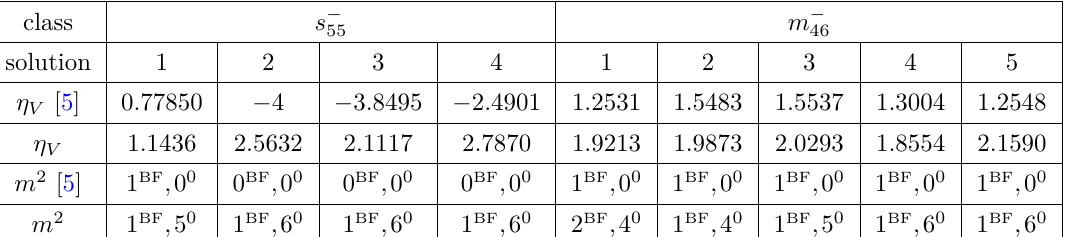
Table 9 . Spectrum information for each anti-de Sitter solution in type IIA/B. We first provide the value of η (note the definition and sign convention in (2.24)) for the fields ( ρ, τ, σ V in [5], then the one obtained here with the complete set of scalar fields of the above dimensional reduction. By i BF , j 0 , we also indicate the number j of massless modes and i of tachyons (those with m 2 below the BF